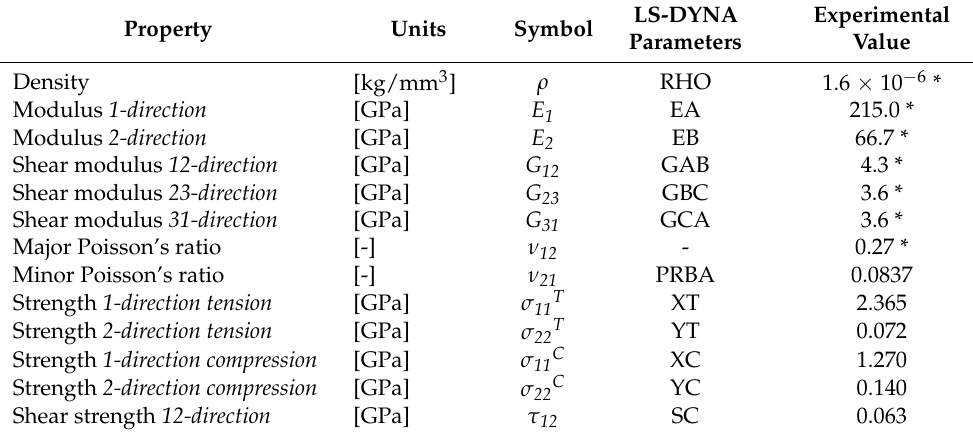
Table 1. Stiffness material properties of M40J/epoxy as published in Frulla et al. (*) [2] and associated strength material threshold